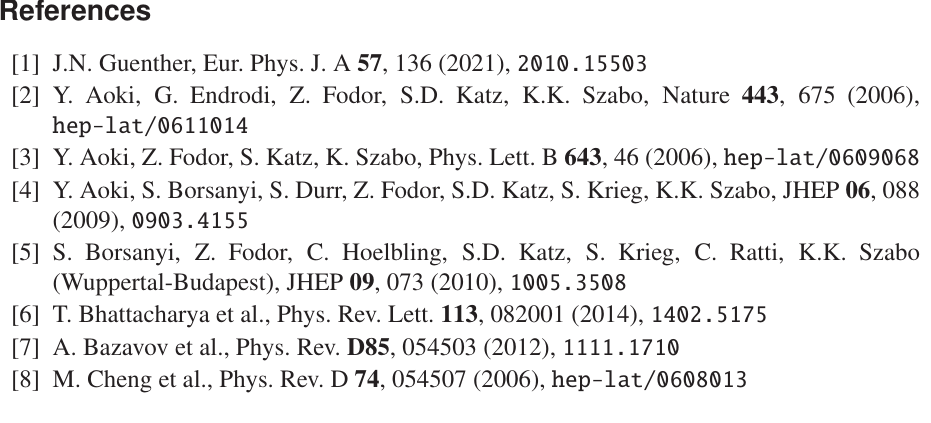
Figure 5. (Ref. [31]) The ratios / M R B ( T ,µ B ) = S B σ 3 B and B 31 κ σ 2 R B ( T ,µ B ) as a function of B B 42 ≡ R B ( T ,µ B ) = M B /σ 2 evaluated along B 12 the transition line in comparison to the data from the STAR collaboration (Ref. [29]).